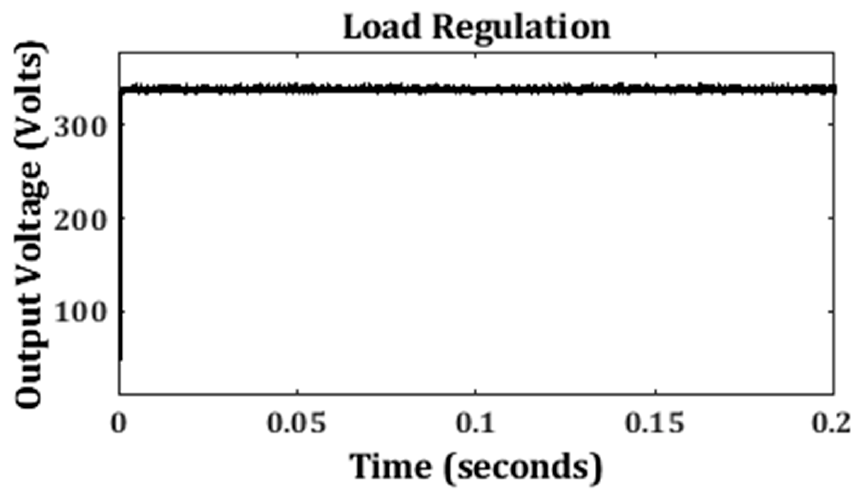
Figure 48. Input current in Amperes during load regulation.